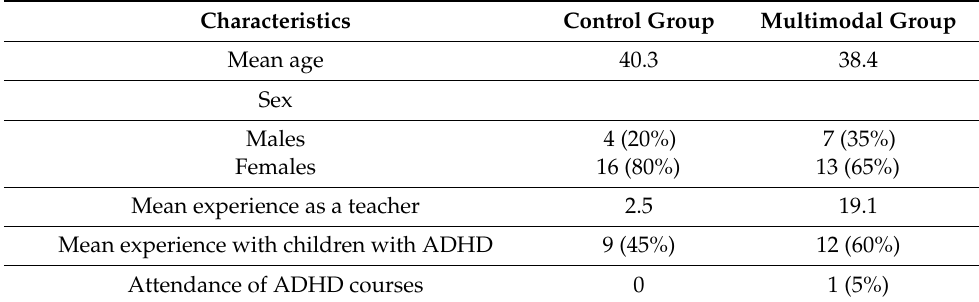
Table 3. Sociodemographic characteristics of the sample of